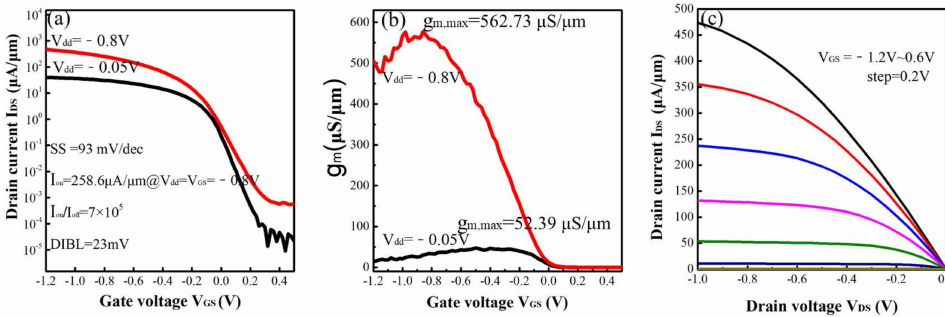
Figure 9. The ( a ) I DS -V GS , ( b ) g m -V GS ( c ) I DS -V DS characteristics of 4-levels vertically stacked Si 0.7 Ge 0.3 NWs GAA device with S/D silicide process.